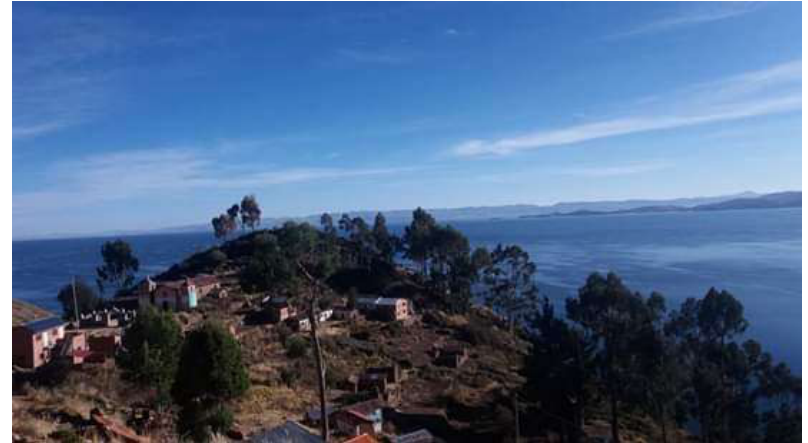
Figure 5: Ayllu Chiquipata. Source: Tania